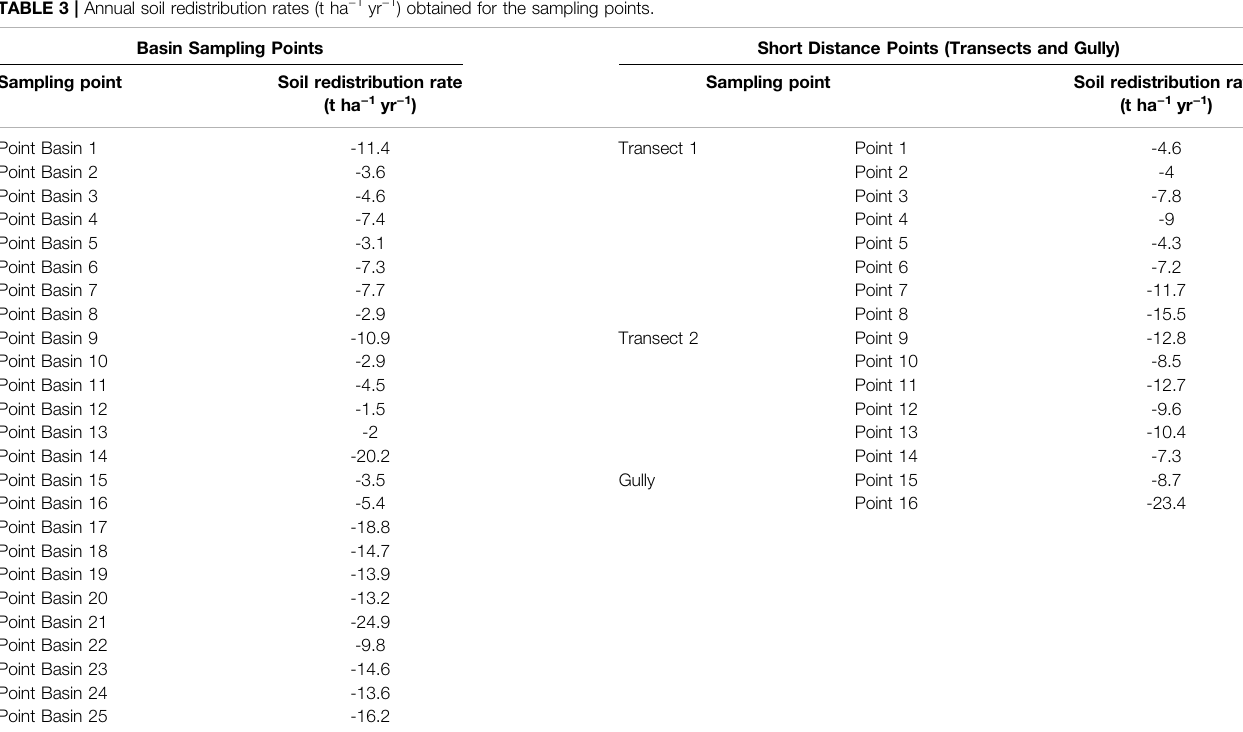
TABLE 3 | Annual soil redistribution rates (t ha − 1 yr − 1 ) obtained for the sampling points. Basin Sampling